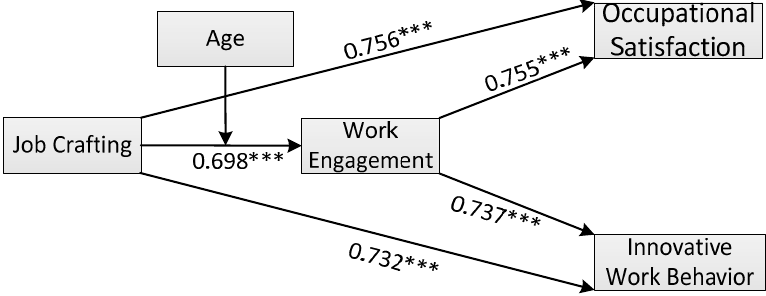
Figure 1. Path diagram and the standardized estimates of Model B. *** p < 0.01.